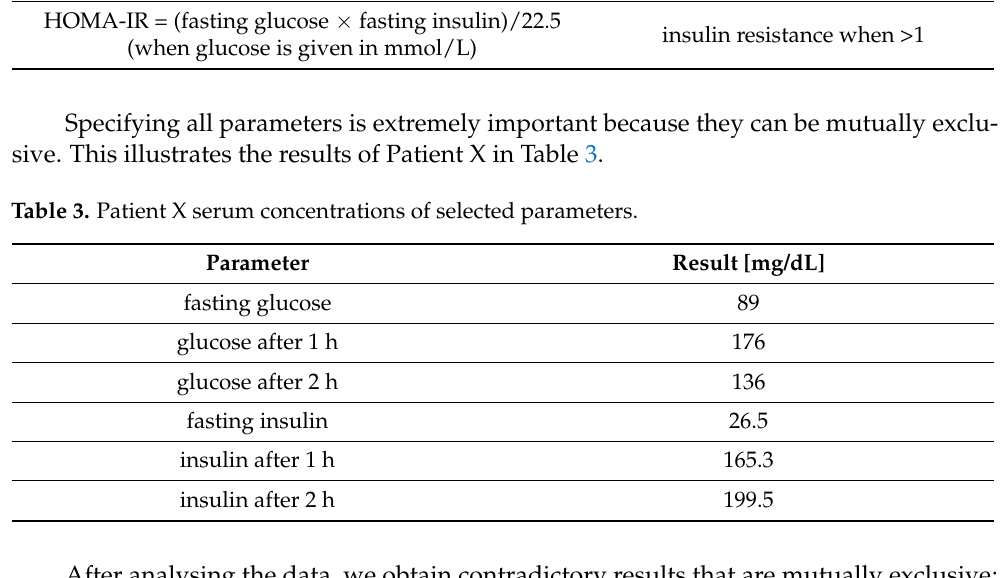
Table 2. Determination of parameters and the occurrence of insulin resistance based on insulin and glucose measurement after OGTT administration [20,61–65]. Parameter The concentration of insulin in the fasted blood 3–17 mLU/L insulin resistance when >0.3 HOMA-IR = (fasting glucose × fasting insulin)/405 insulin resistance when >1 (when the glucose concentration is given in mg/dL) HOMA-IR = (fasting glucose × fasting insulin)/22.5 insulin resistance when >1 (when glucose is given in mmol/L)